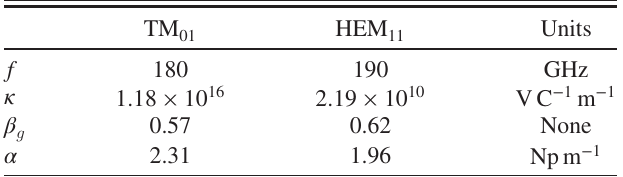
TABLE III. A-STAR synchronous electromagnetic mode char- acteristics. The loss factor κ for the HEM 11 mode scales with the square of the beam offset and is given for the offset of 1 μ m. The attenuation coefficient α is given for a structure with the conductivity of 4 × 10 7 S m − 1